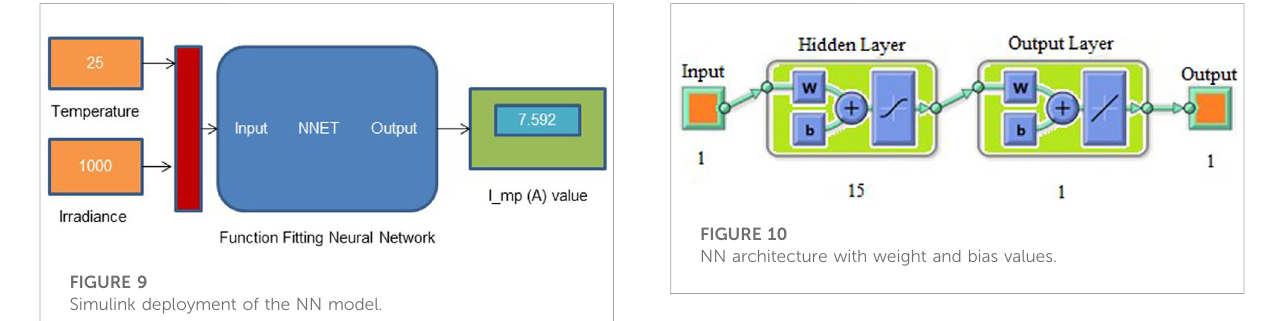
FIGURE 9 Simulink deployment of the NN model.